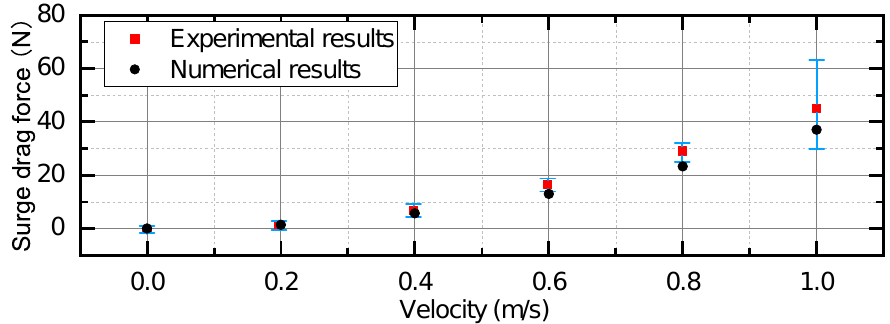
Figure 13. Comparison of surge force between the numerical and experimental results.